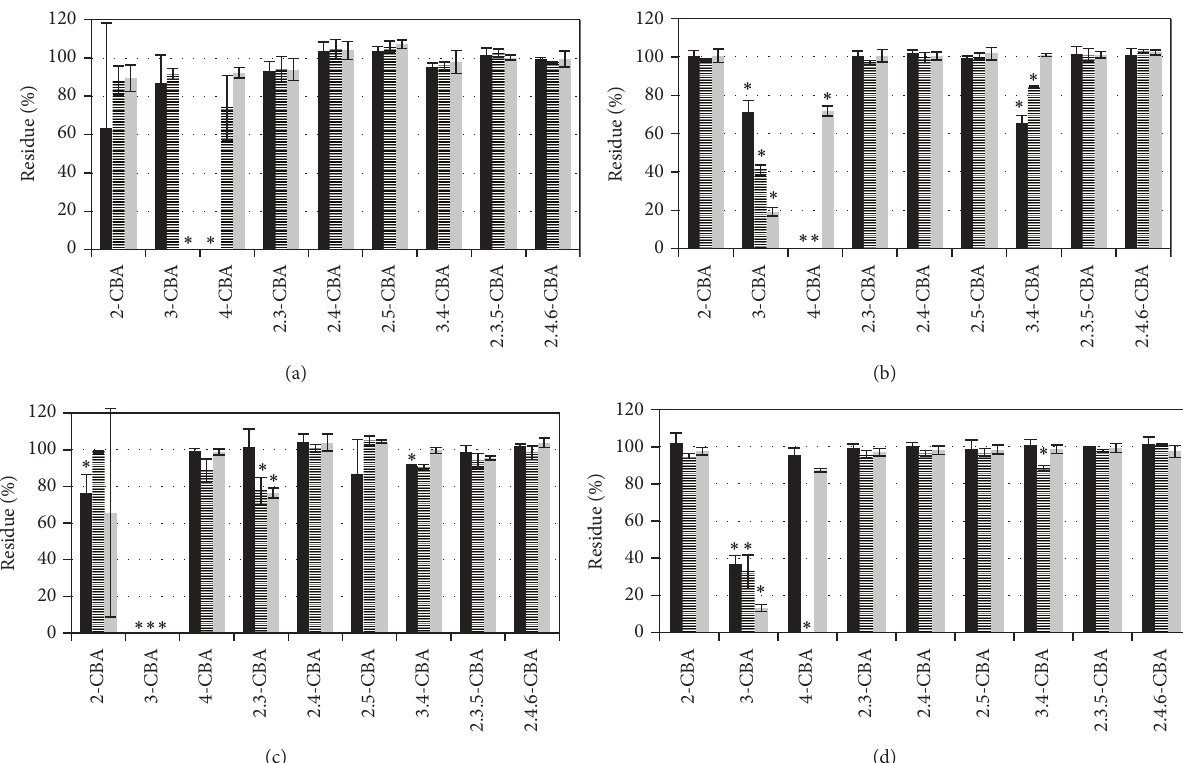
Figure 3: Degradation of single CBA ((a), (c)) and mixture of CBA ((b), (d)) by strains UH82 ( Arthrobacter sp.) ((a), (b)) and UH133 ( Pandoraea sp.) ((c), (d)). Black bar in minimal medium, stripped bar in minimal medium with exudates of black nightshade ( Solanum nigrum ), and grey bar in minimal medium with exudates of tobacco ( Nicotiana tabacum ). Stars indicate the statistically significant CBA removal